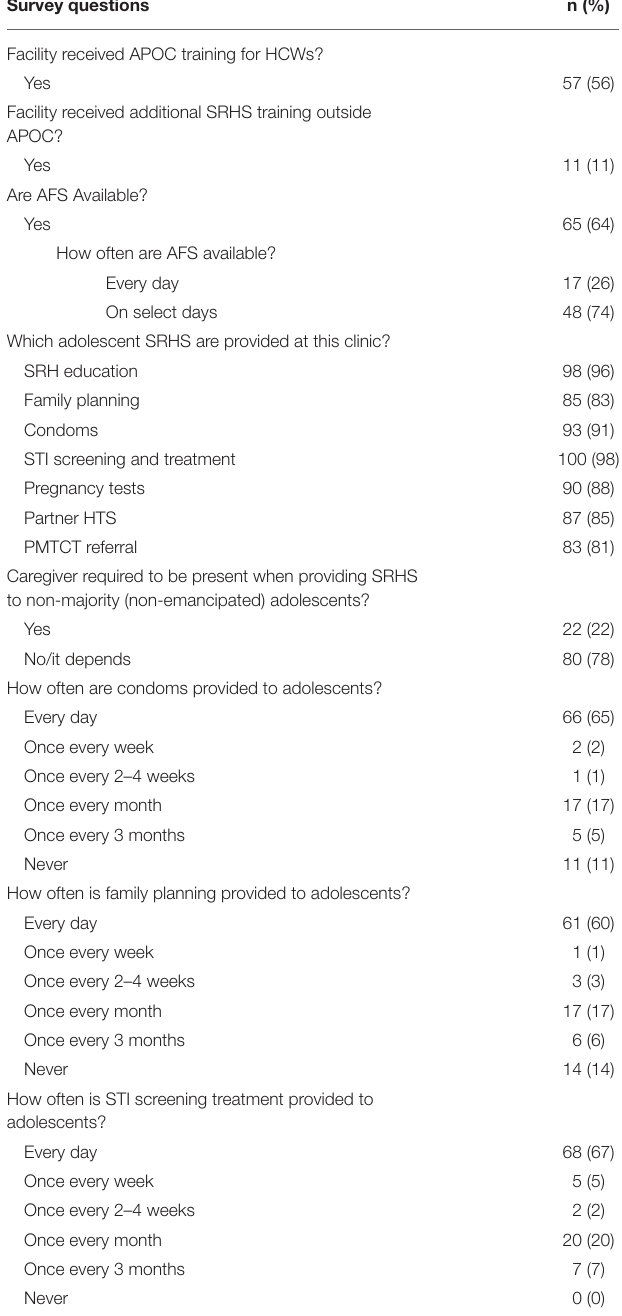
TABLE 1 | SRH facility survey data ( n =